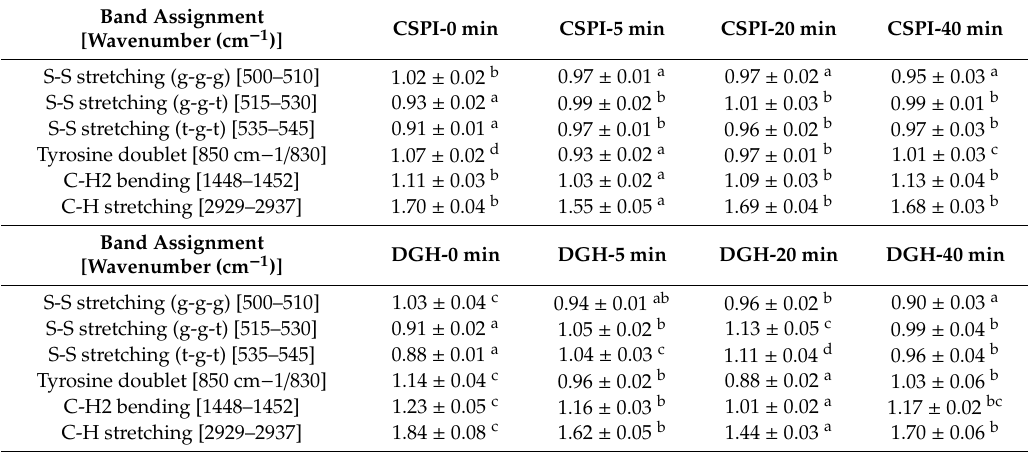
Table 5. Normalized intensity values at selected regions of the FT-Raman spectra of high-intensity ultrasound (HIU; 20 kHz at 400 W for 0, 5, 20, 40 min) treated CSPI and